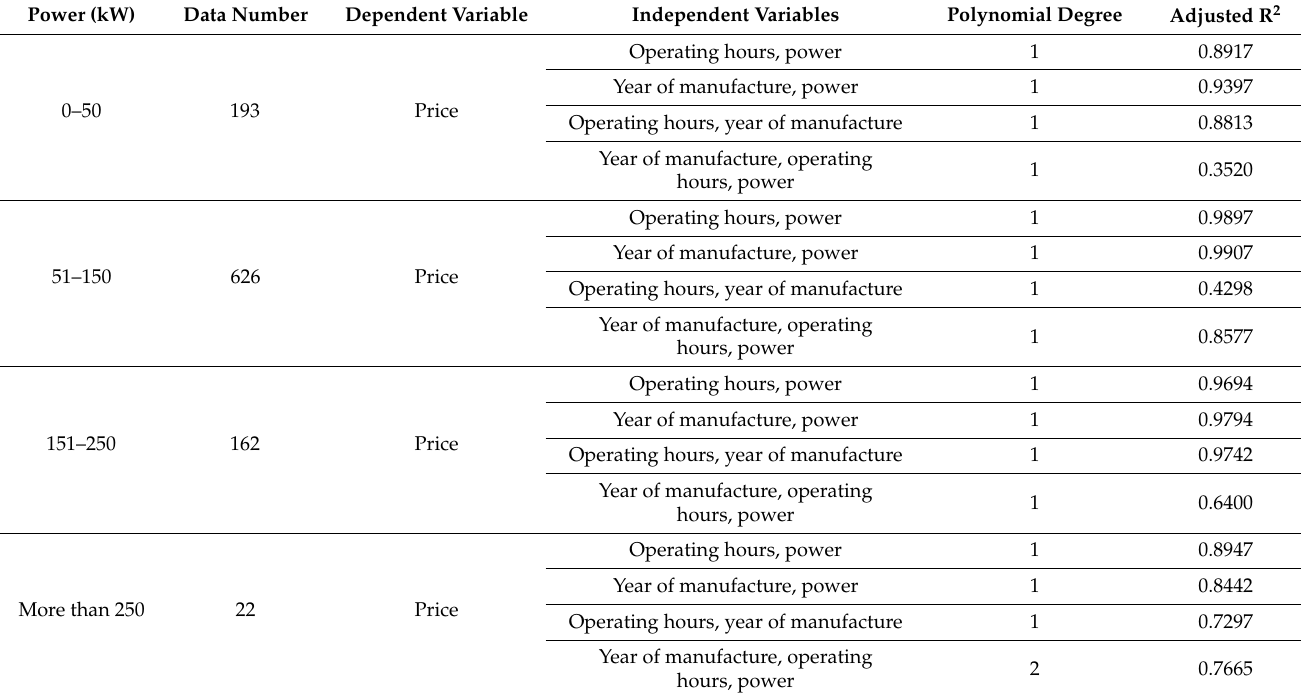
Table 12. Summary of results for segmentation by power range in second-hand